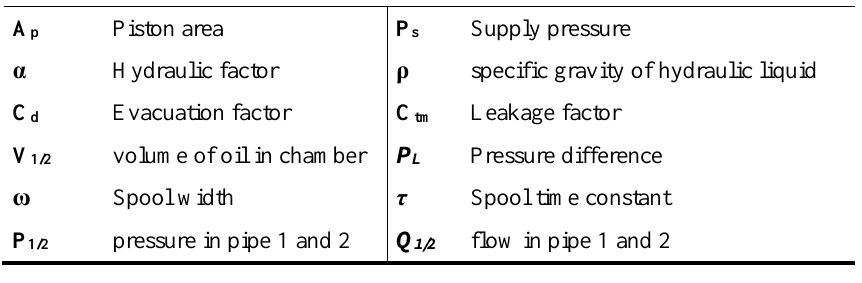
Table 1. System parameters